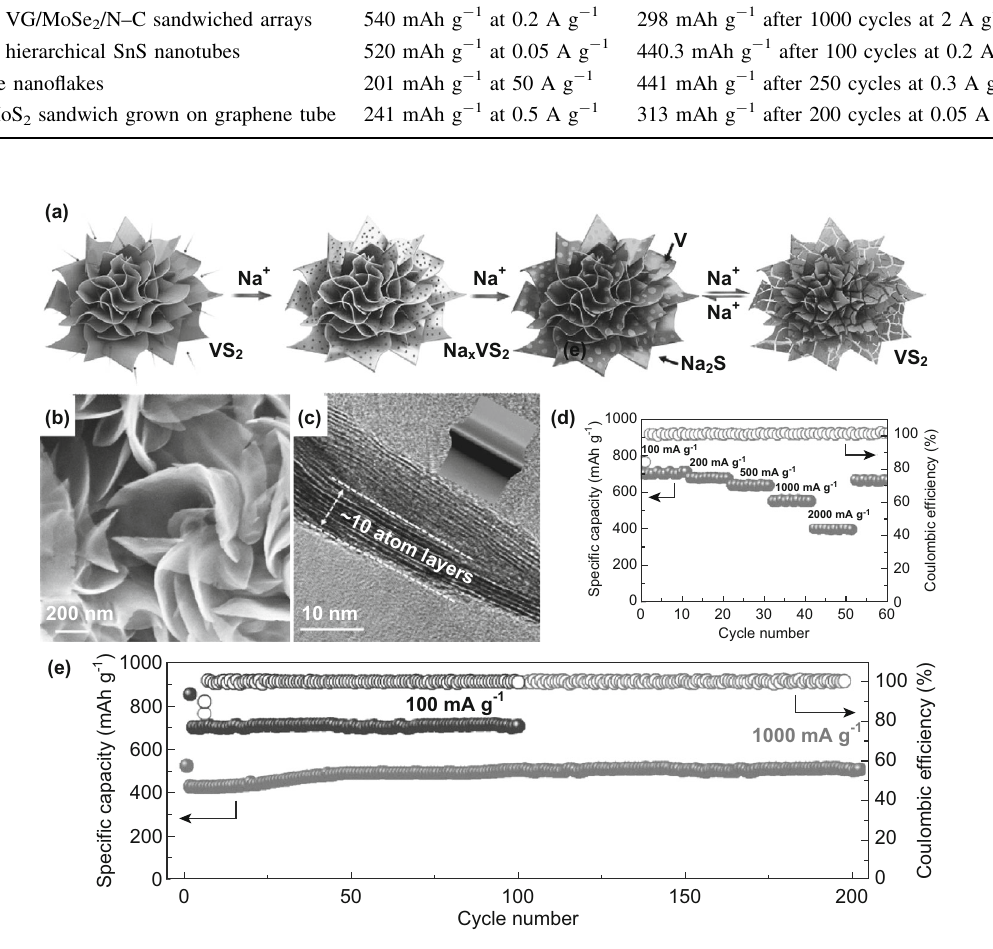
Fig. 11 3D architectures based on 2D VS 2 nanoflake self-assemblies for SIBs. a Schematic illustration of reversible Na ? ion storage in VS 2 nanoflake assemblies. b SEM images and c TEM images of VS 2 nanoflake assemblies. d Rate capability from 100 to 2000 mA g - 1 and corresponding Coulombic efficiency. e Cycling stability and corresponding Coulombic efficiency at 100 mAh g - 1 and 1000 mA g - 1 . Reproduced with permission [128]. Copyright (cid:2) 2017, John Wiley & Sons,